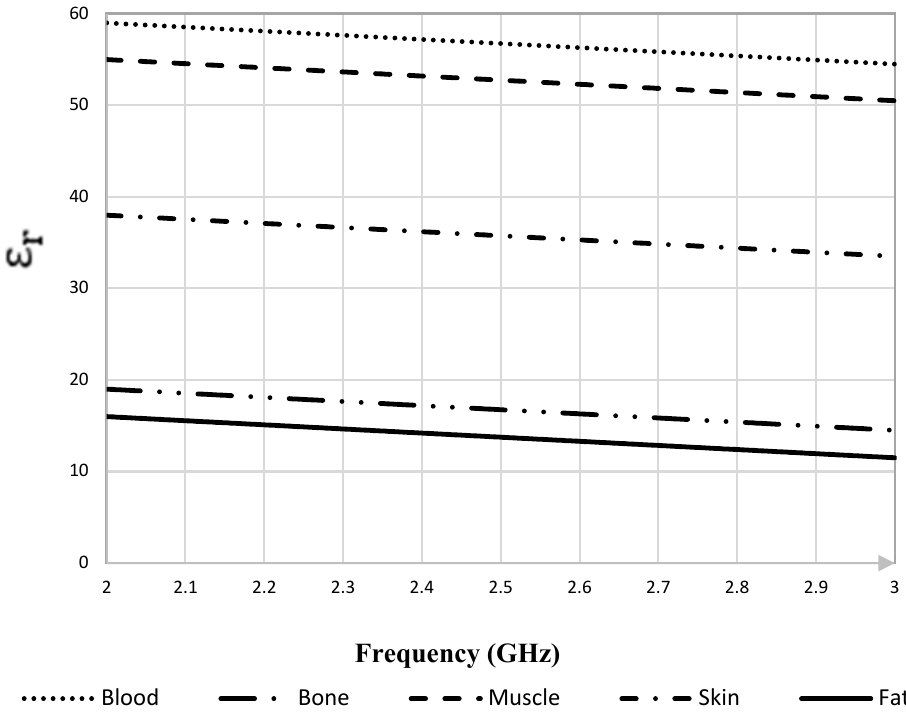
Figure 1. Relative permittivity ( ε r ) in the frequency range from (2–3) GHz of the biological tissues selected for the heterogeneous simulated samples.